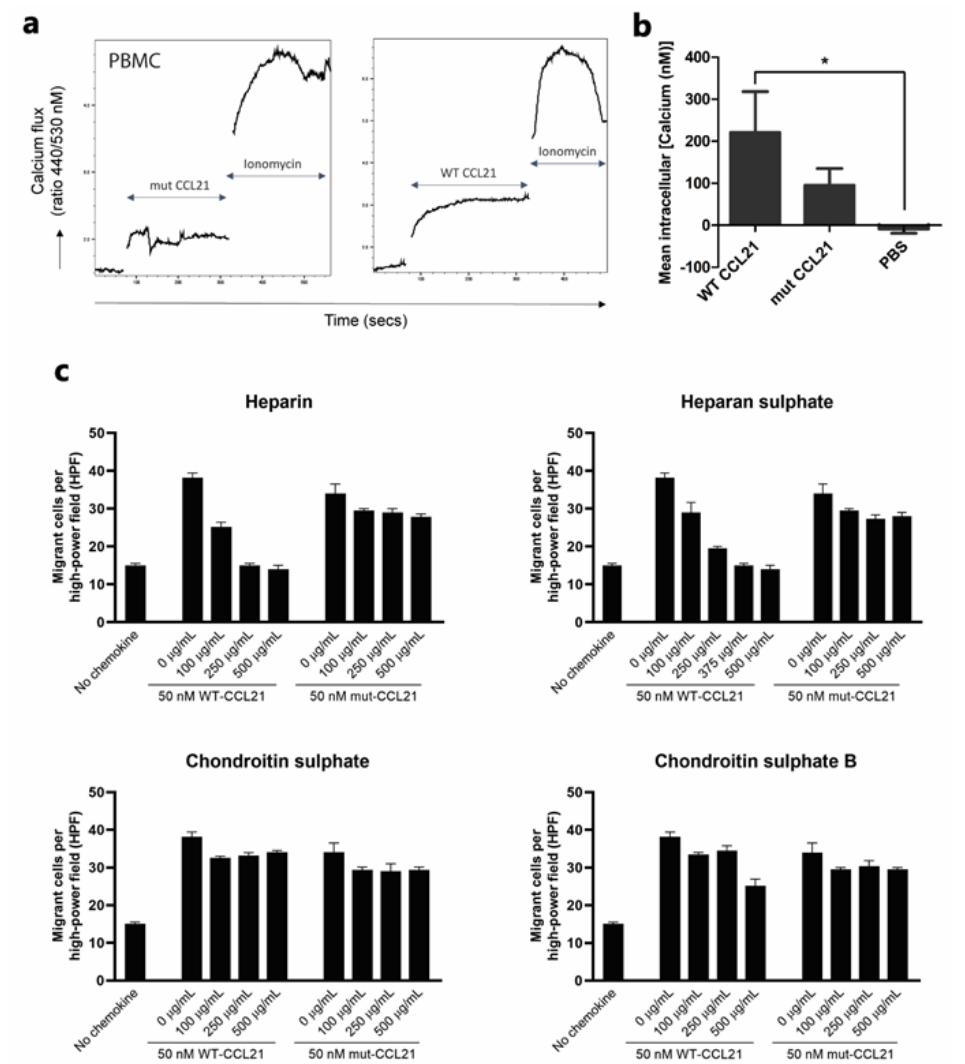
Figure 4. Biological activity of mutant and WT-CCL21 in PBMCs. Calcium flux. PBMCs were loaded with Indo-1am and stimulated with 50 nM of either PBS, WT or mut-CCL21, followed by ionomycin as a positive control. ( a ) Representative flow cytometry plots of the change in 450/50 to 530/30 ratio after stimulation with mut-CCL21 (left) or WT-CCL21 (right), followed by ionomycin. ( b ) Data represent the intracellular calcium concentration ± SEM of three independent experiments and statistical significance was assessed with one-way ANOVA with Tukey’s multiple comparison test. ( c ) Heparinoid inhibition. Inhibition of the chemotactic response of PBMCs towards 50 nM of either WT or mut-CCL21 after incubation with several concentrations of heparin (top left), heparan sulphate (top right), chondroitin sulphate A (bottom left) or chondroitin sulphate B (bottom right). * p <